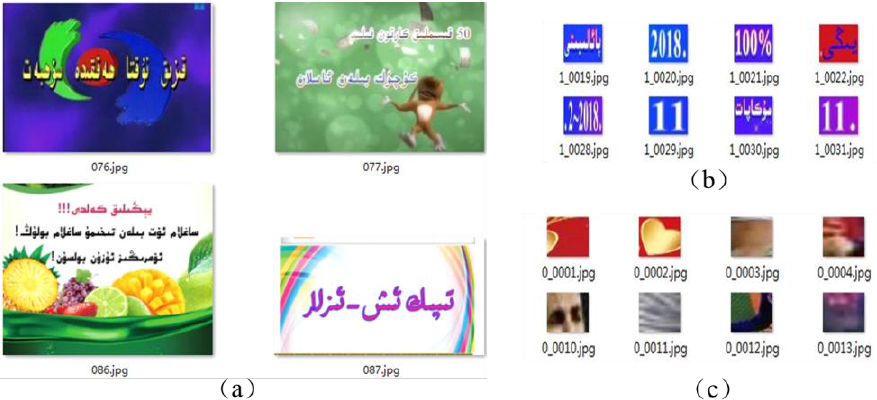
Figure 5. Examples of the detection dataset. ( a ) examples of color images; ( b ) positive samples in training set; ( c ) negative samples in training set.